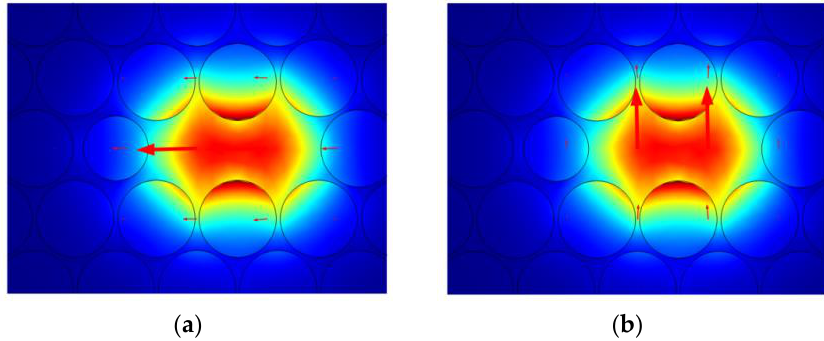
Figure 9. The optical-field distributions of fundamental modes at 1550 nm for ( a ) x -polarization, and ( b ) y -polarization.